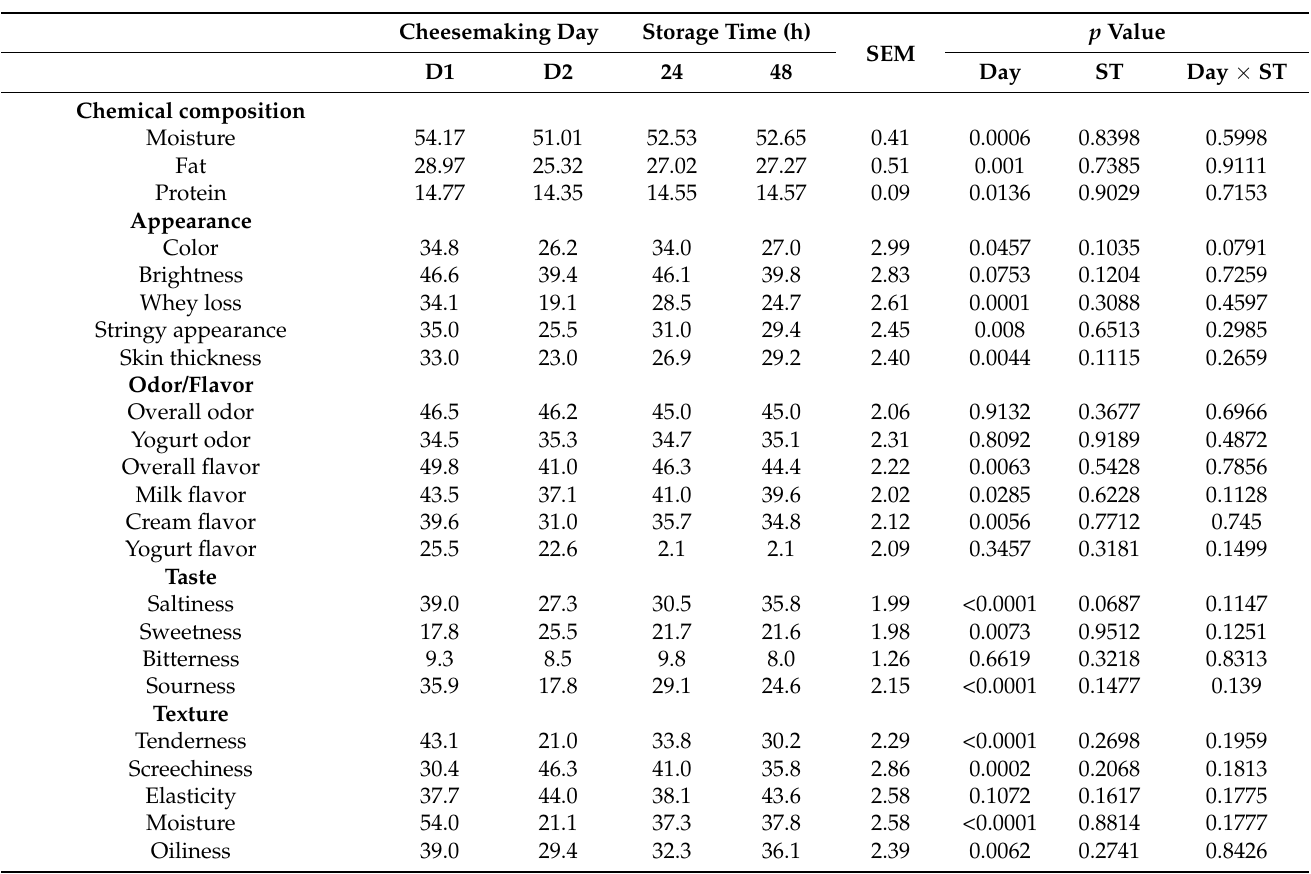
Table 7. Chemical composition and sensory profile of mozzarella cheese (LSM) affected by cheese- making day and conservation